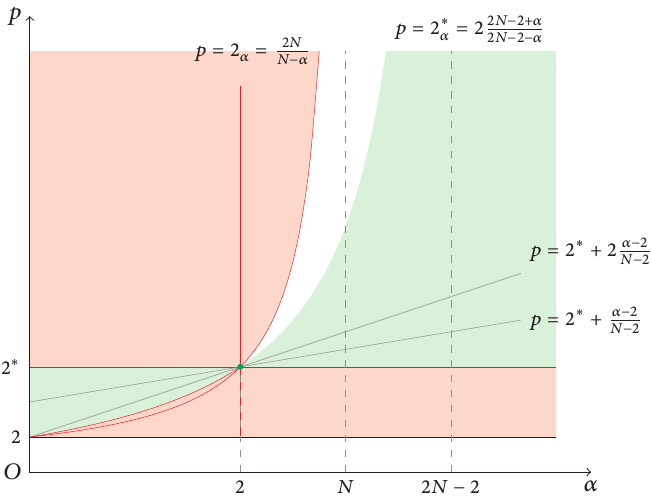
Figure 1. Existence (light green), nonexistence (light red) regions. Green dot means existence, red line means nonexistence.